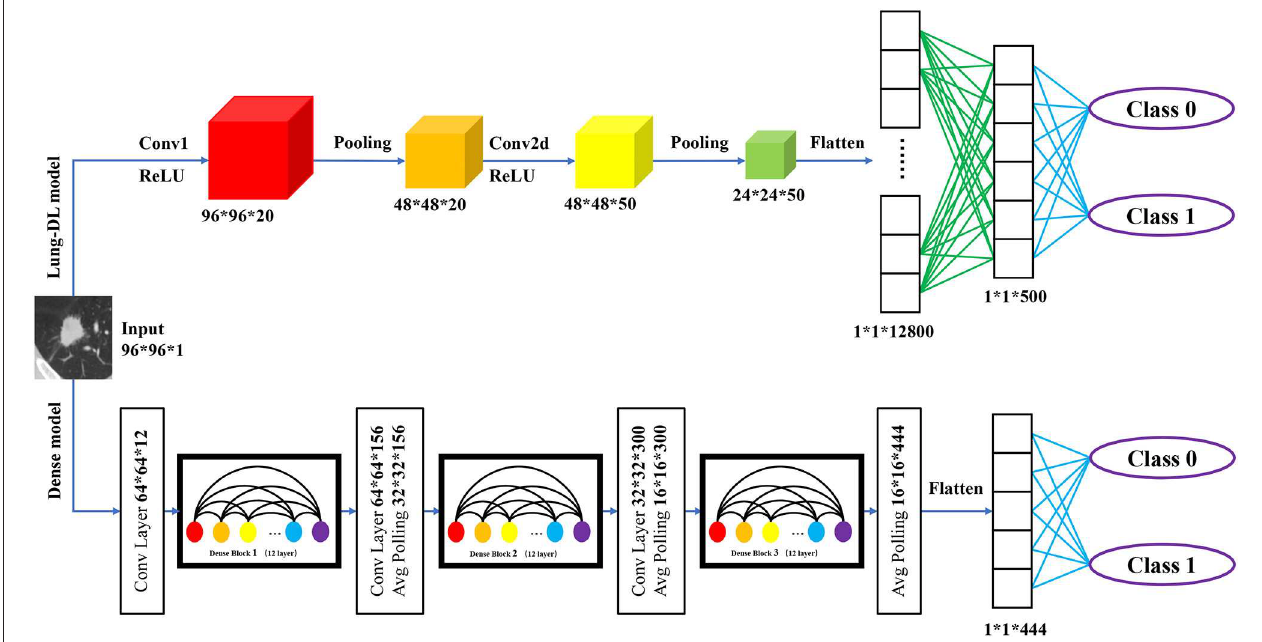
FIGURE 3 | Structure of two deep learning model structure. The Lung-DL model on the top of the picture consists of two convolutional layers, each followed by an average pooling layer. Two fully connected layers were attached to the end of the network; The Dense model on the bottom consists of three dense blocks. Each block consists of 12 convolutional layers. A fully connected layer was attached to the end of the